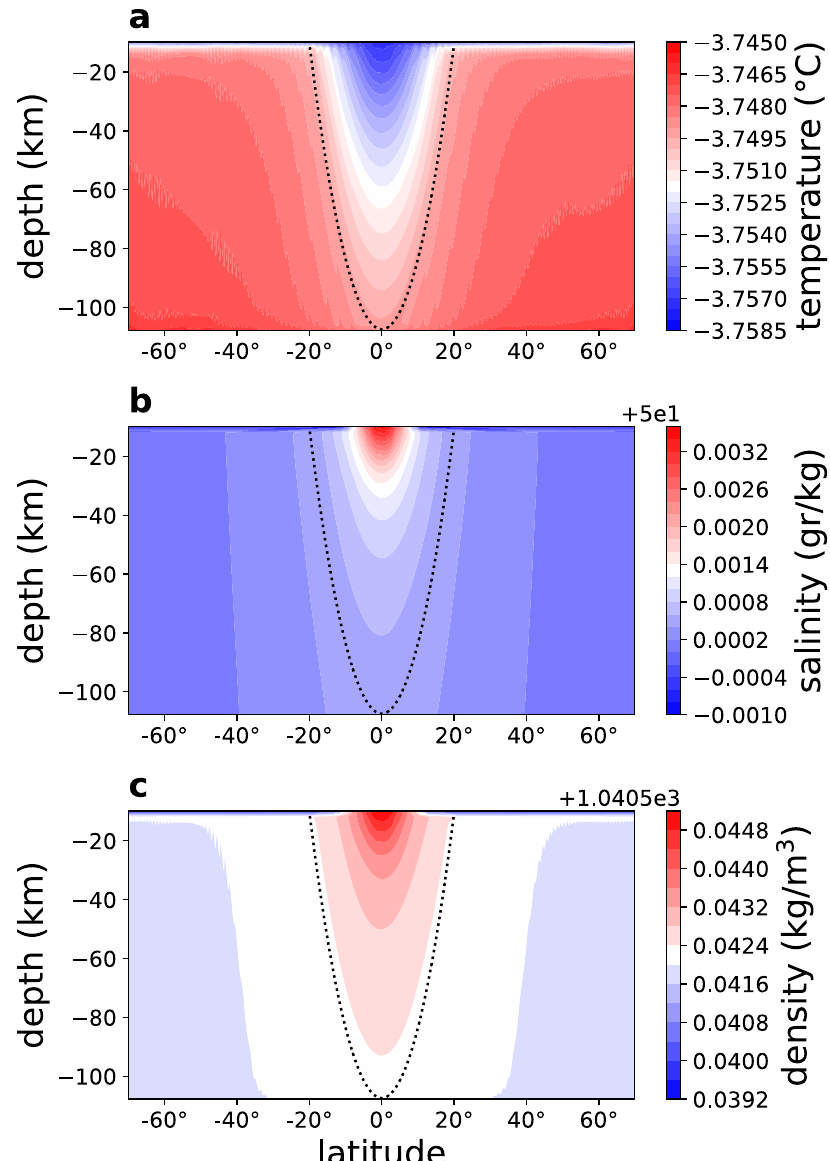
Fig. 1 2d simulation results — tracers. Latitude-depth snapshot plots of a temperature (°C), b salinity (g kg − 1 ), and c density (kg m − 3 ). The dotted lines in these panels shows the tangent